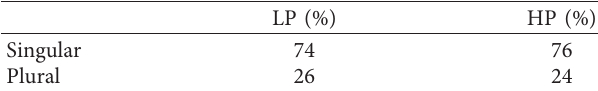
Table 7: Number errors for plural nouns by proficiency.